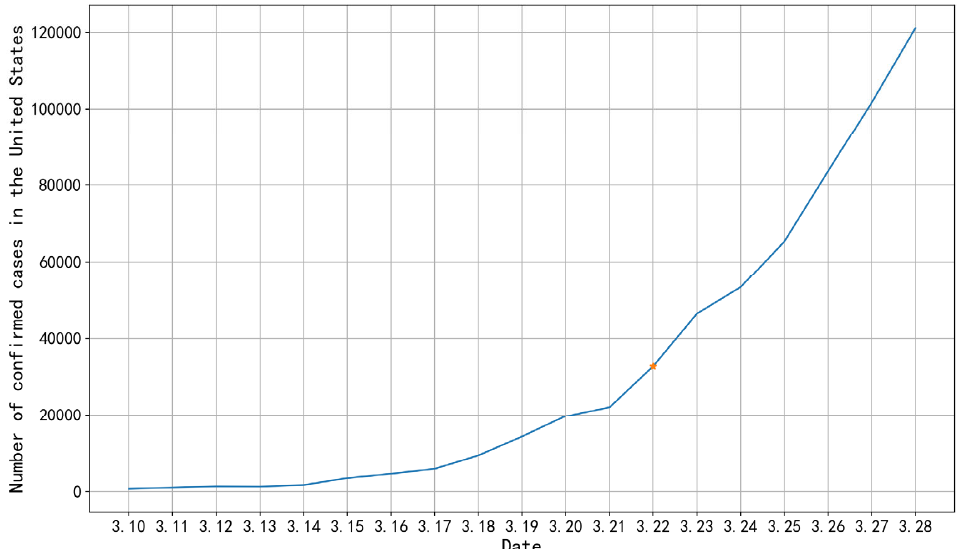
Figure 5. Number of confirmed cases in the United States from 10 March to 28.